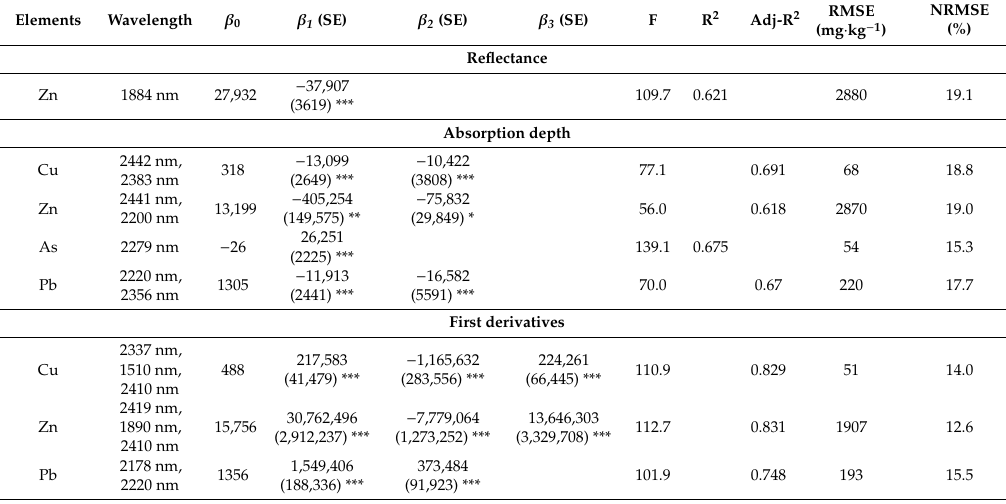
Table 4. Parameter for fitting the reflectance, absorption depth, and first derivatives to heavy